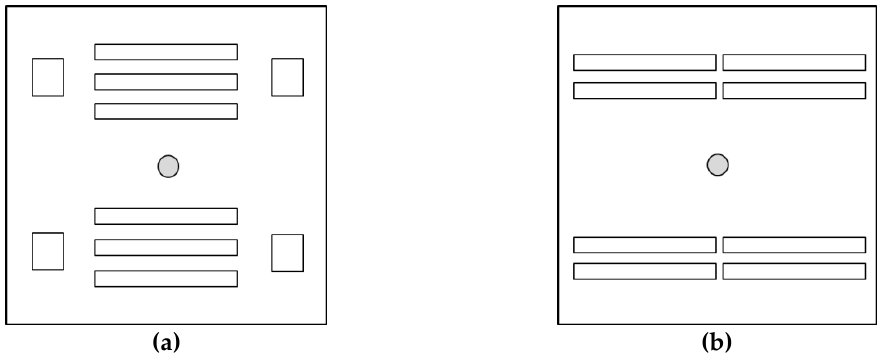
Figure 2. Geometry of the film gate plates used for the short-shot and core-back chemical foaming trials. Sampling positions are shown for flexural and impact testing (80 × 10 mm²) ( a ) and for density measurements and microscopy (20 × 20 mm²) ( b ).